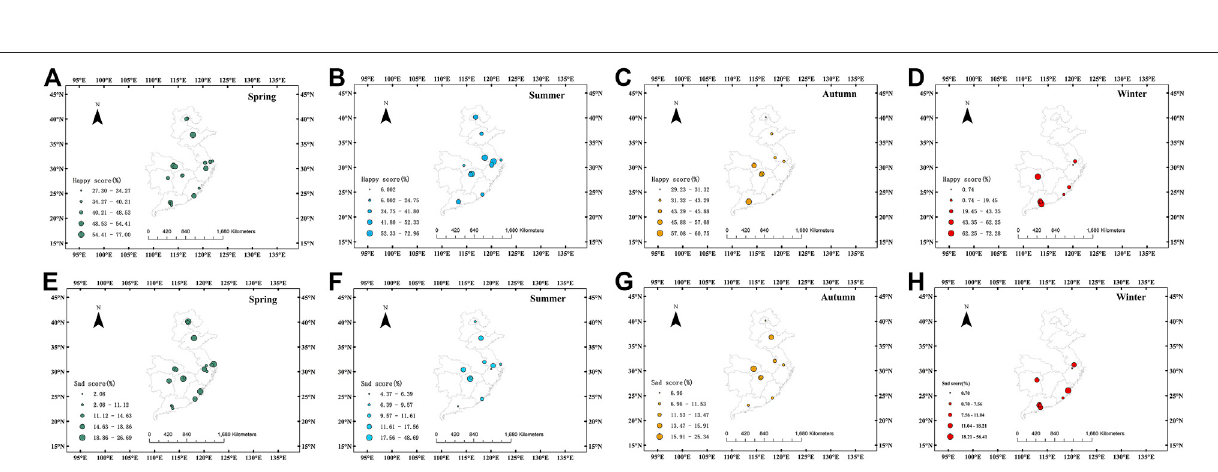
Frontiers in Earth Science |